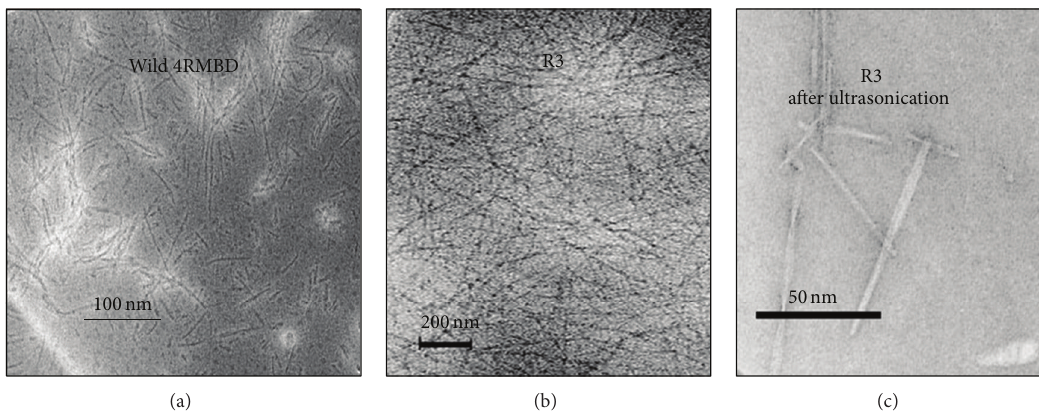
Figure 4: The electronic microscopic picture of different tau filaments (a). The filments of wild 4RMBD (b). The filaments of R3 (c). The filaments of R3 after ultrasonication.